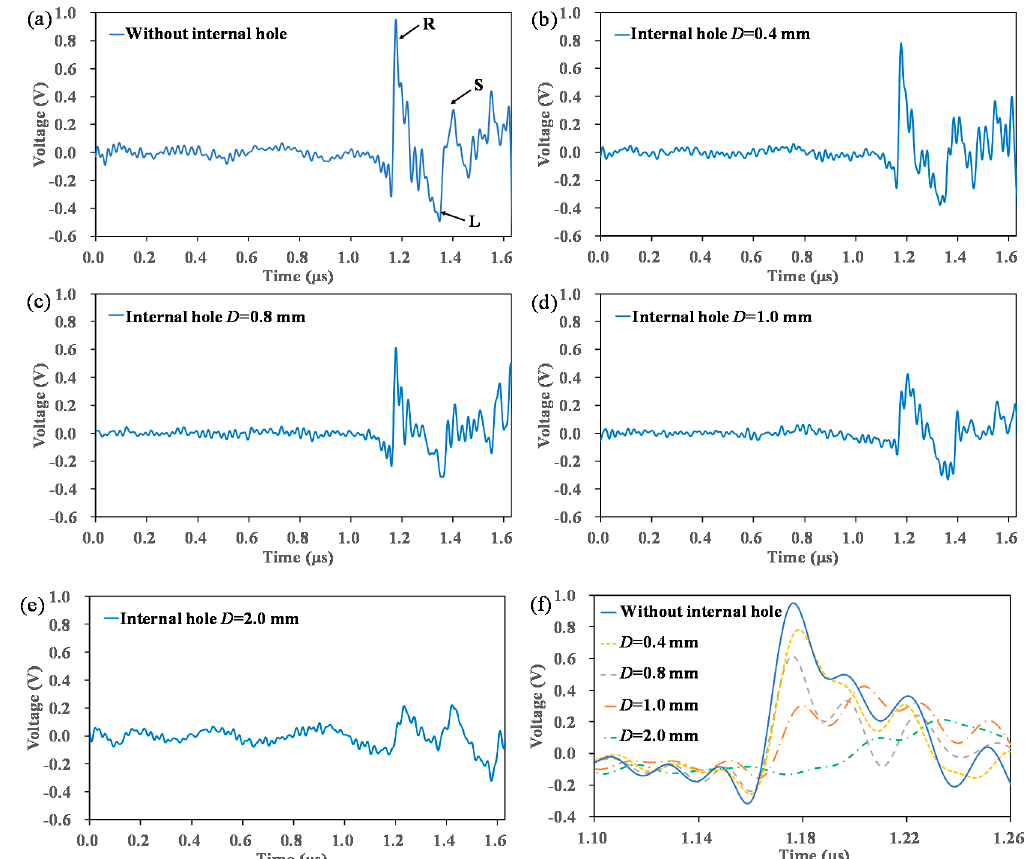
Figure 4. A-Scan signals contain of Rayleigh (R) wave, longitudinal (L) wave, and shear (S) wave of different positions located at the scanning path ( Y = 5 mm, along X -axis in Figure 3): ( a ) without internal hole, ( b ) internal hole D = 0.4 mm, ( c ) internal hole D = 0.8 mm, ( d ) internal hole D = 1.0 mm, ( e ) internal hole D = 2.0 mm, and ( f ) local amplification of Rayleigh